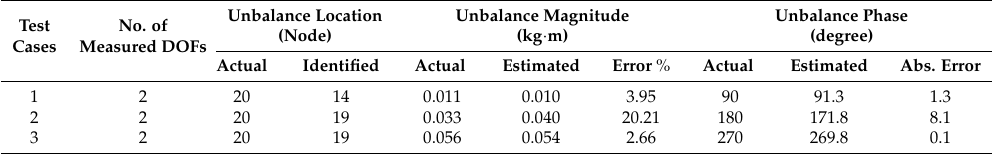
Table 10. Estimation results for different values of unbalance magnitudes and phases induced in the paper machine’s tube roll. The displacement minimization method is used for the estimation, and each case has two measured